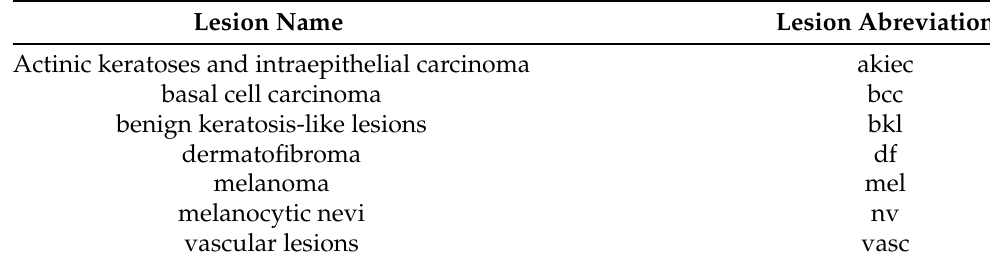
Table 1. Image classes of HAM10000